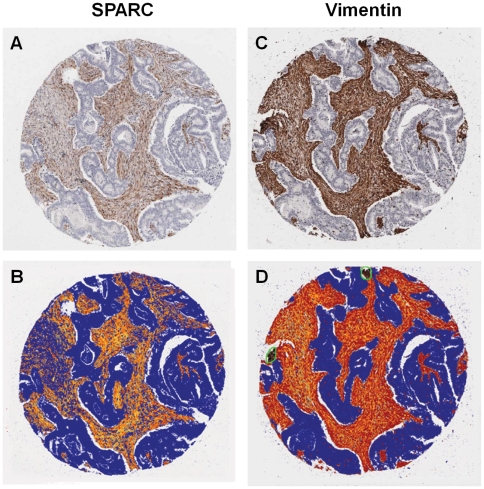
Tissue microarray analysis.SPARC and vimentin staining from a single patient. Images demonstrate serial DAB-stained tissue sections for both (A) SPARC and (C) vimentin and computer analysed images of the respective DAB staining (B and C). Blue represents DAB-negative pixels (dark areas), orange DAB-positive pixels and red strongly DAB-positive pixels (light areas). SPARC expression was selectively measured only in the regions of the tissue that were also vimentin-positive.